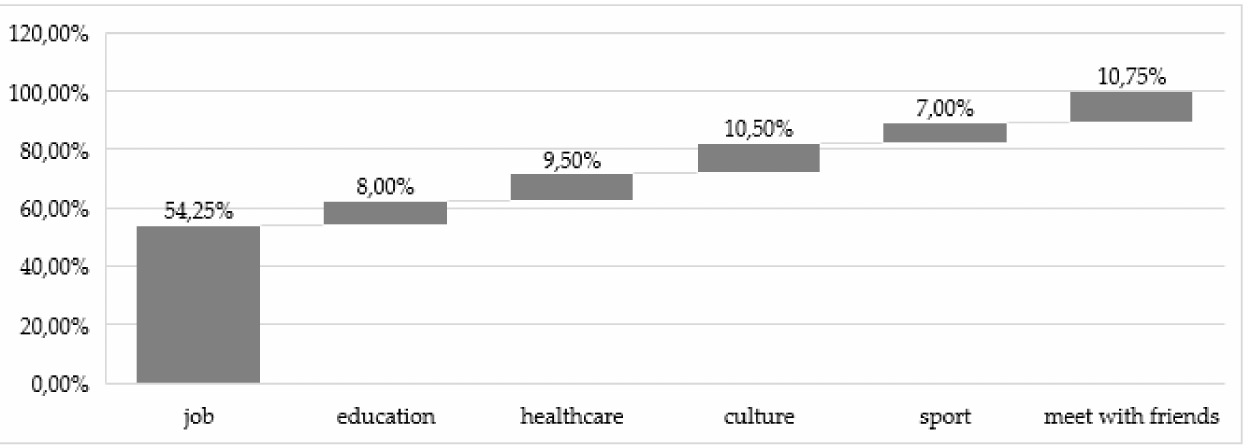
Figure 8. Frequency of using public transport.